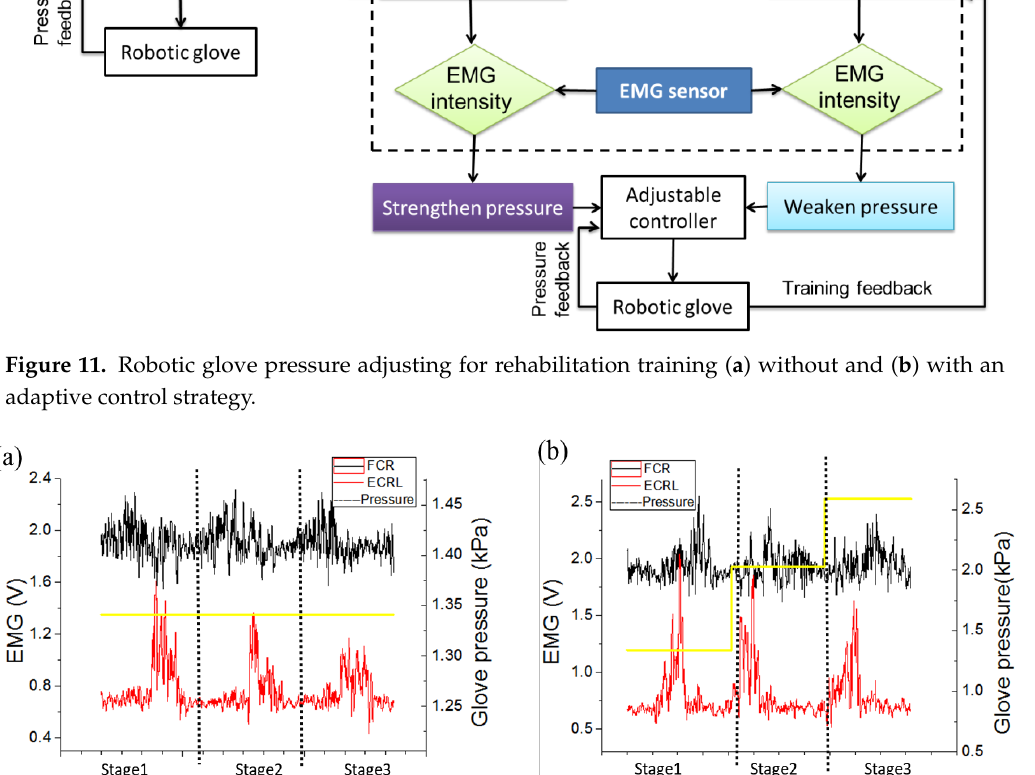
Figure 11. Robotic glove pressure adjusting for rehabilitation training ( a )without and ( b ) with an adaptive control strategy.